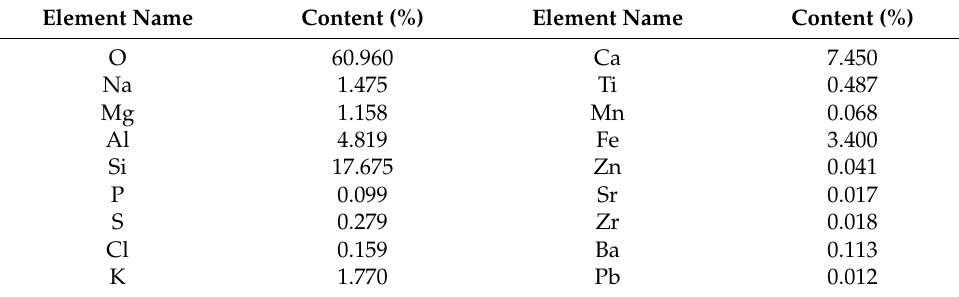
Table 3. Proportion of chemical elements in silt.